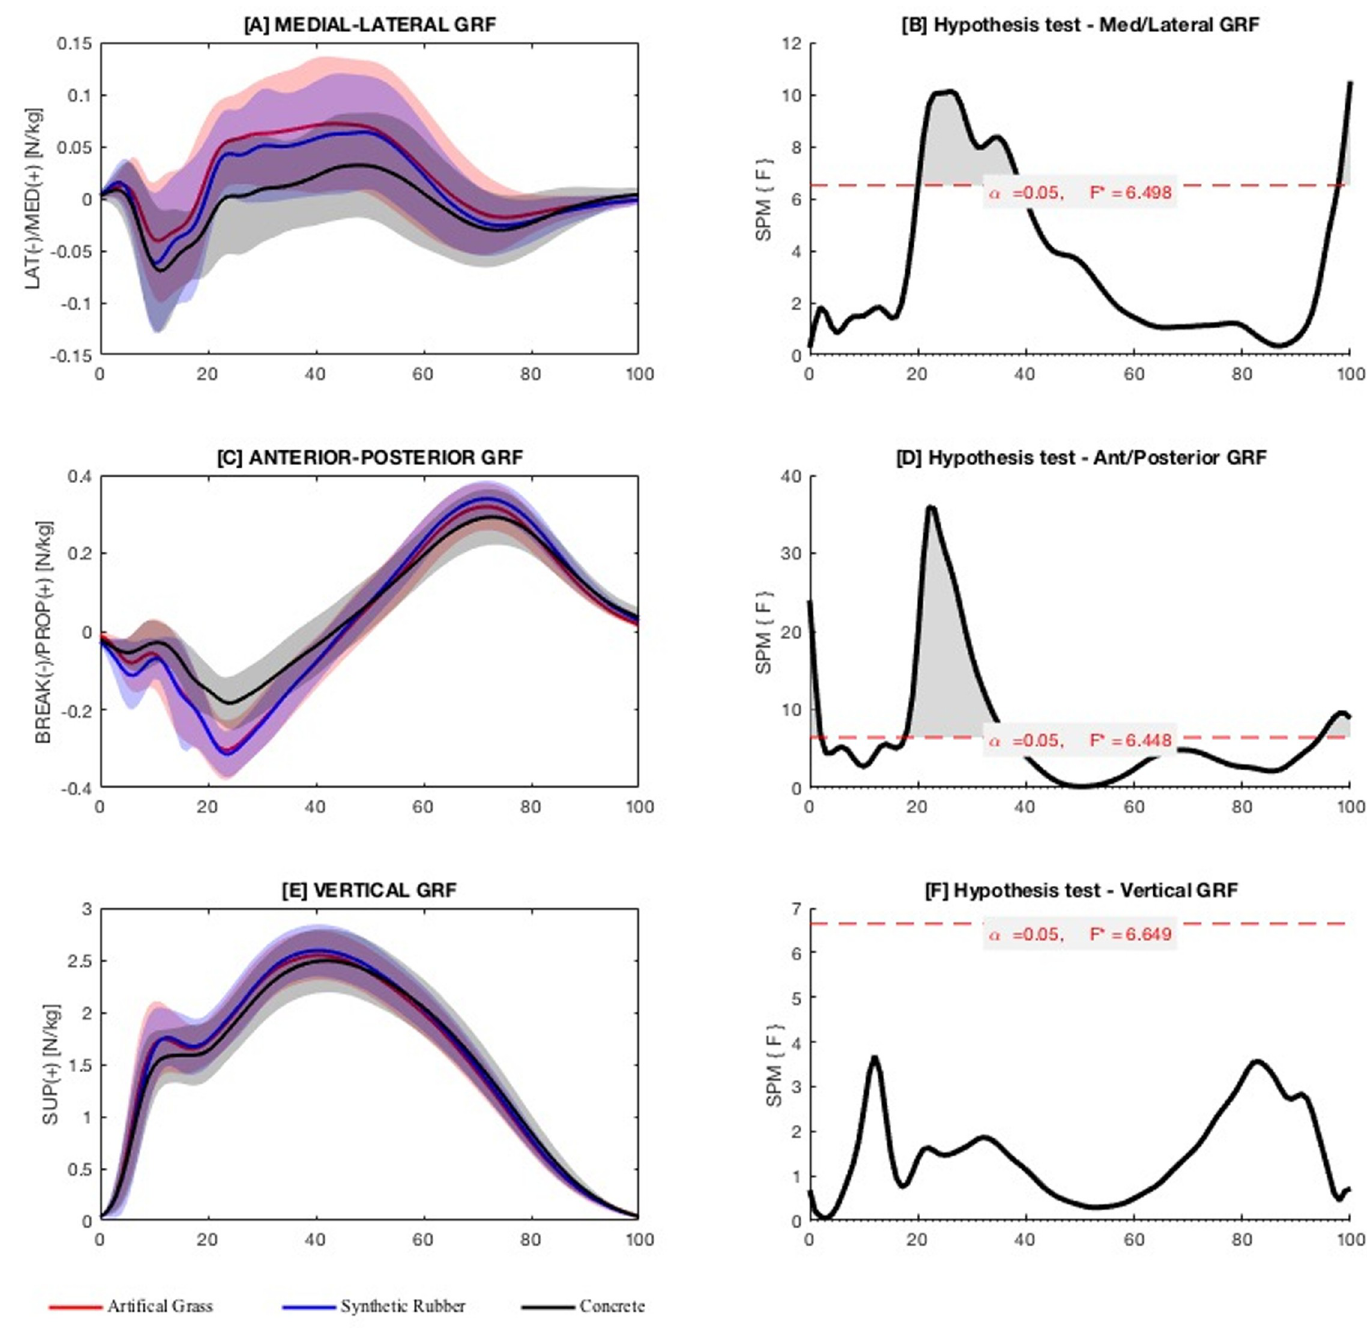
Fig 2. Ground reaction forces. Ensemble time series of 3D GRF forces (A, C, E) and the corresponding results of statistical parametric mapping analysis (B, D, F) across participants during running on artificial grass, synthetic rubber and concrete surfaces. Areas of significant differences are marked in shaded grey. F � = critical